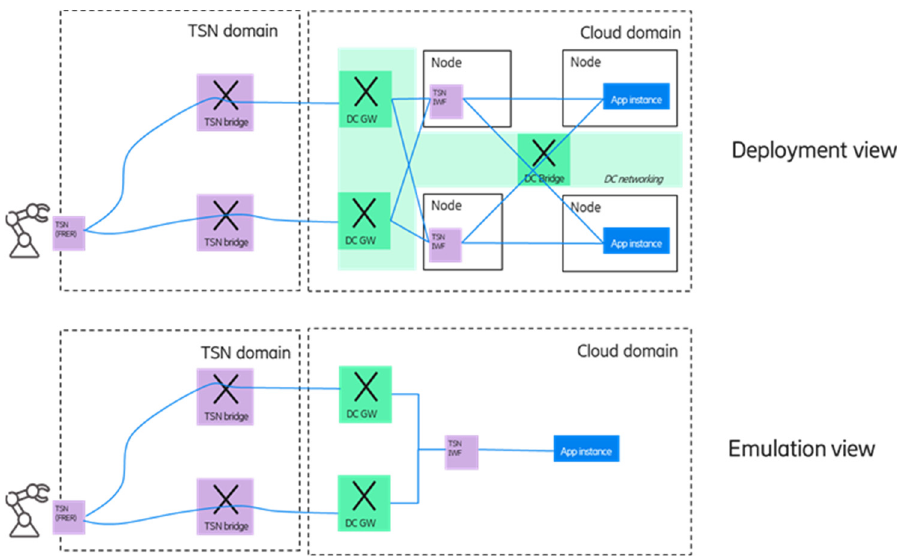
Figure 10. Single, emulated application handling scenario.